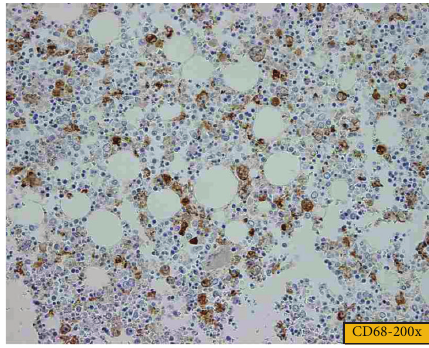
Figure 1: Hemophagocytosis in the bone marrow of Case